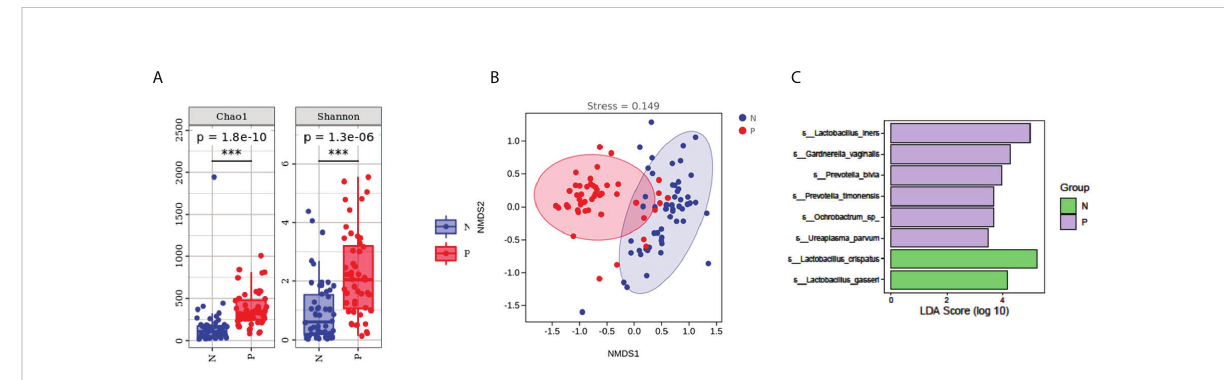
FIGURE 2 Comparisons of a - and b -diversities between the PPROM and term delivery groups. (A) Comparisons of a -diversity groups. ***It indicates that there is a signi fi cant difference between the two groups. (B) Comparisons of b -diversity between groups. (C) Differences in bacterial abundance in patients with PPROM versus controls.